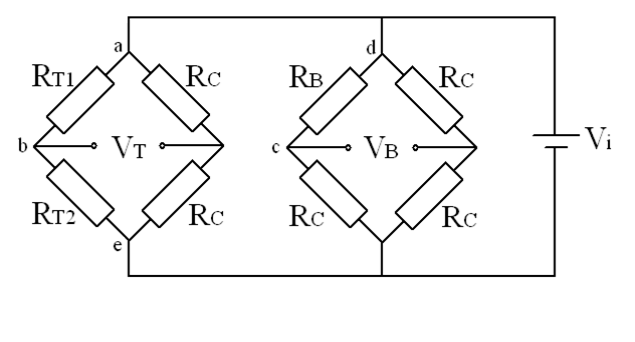
Figure 4. Piezoresistors connection of two Wheatstone